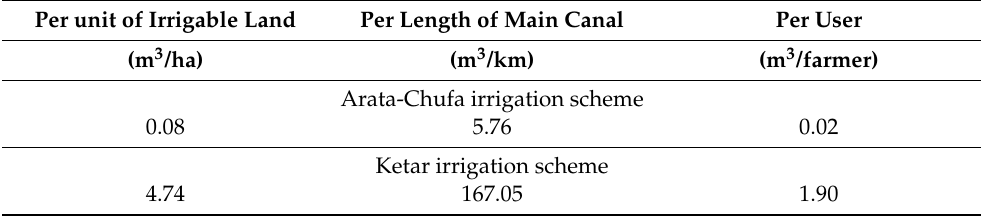
Table 3. Overland sediment inflow to the schemes per unit of irrigable land, per length of main canal and per user.